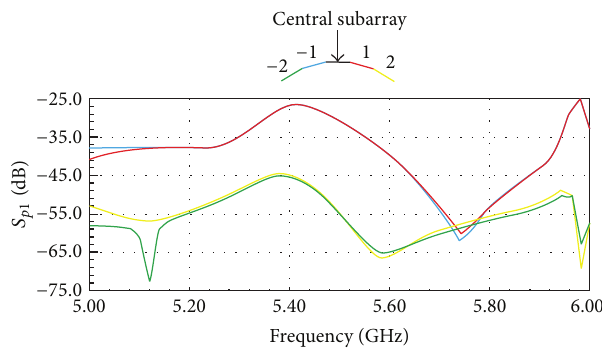
Figure 8: Simulated couplings within the virtual arrays, S lated at the subarray coaxial feed port. Curve colors correspond to relative position on the subarray (above the graph) with respect to the central (black) subarray; red curve is the first subarray to the right, yellow curve the second to the right, and so on.